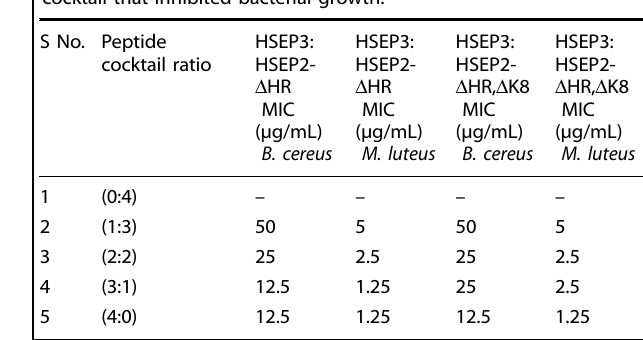
and M. luteus . The results tabulated in Table 3 show that out of the three tested cocktails, the one with ratio 3:1 achieves the same activity as observed with pure HSEP3 preparations (i.e., 4:0). The observed trend was the same for both bacterial species. From this, it is evident that about 75% of the total peptide is suf fi cient for membrane destabilization, while the rest 25% is involved in trypsin inhibition. Further, we tested another set of cocktails